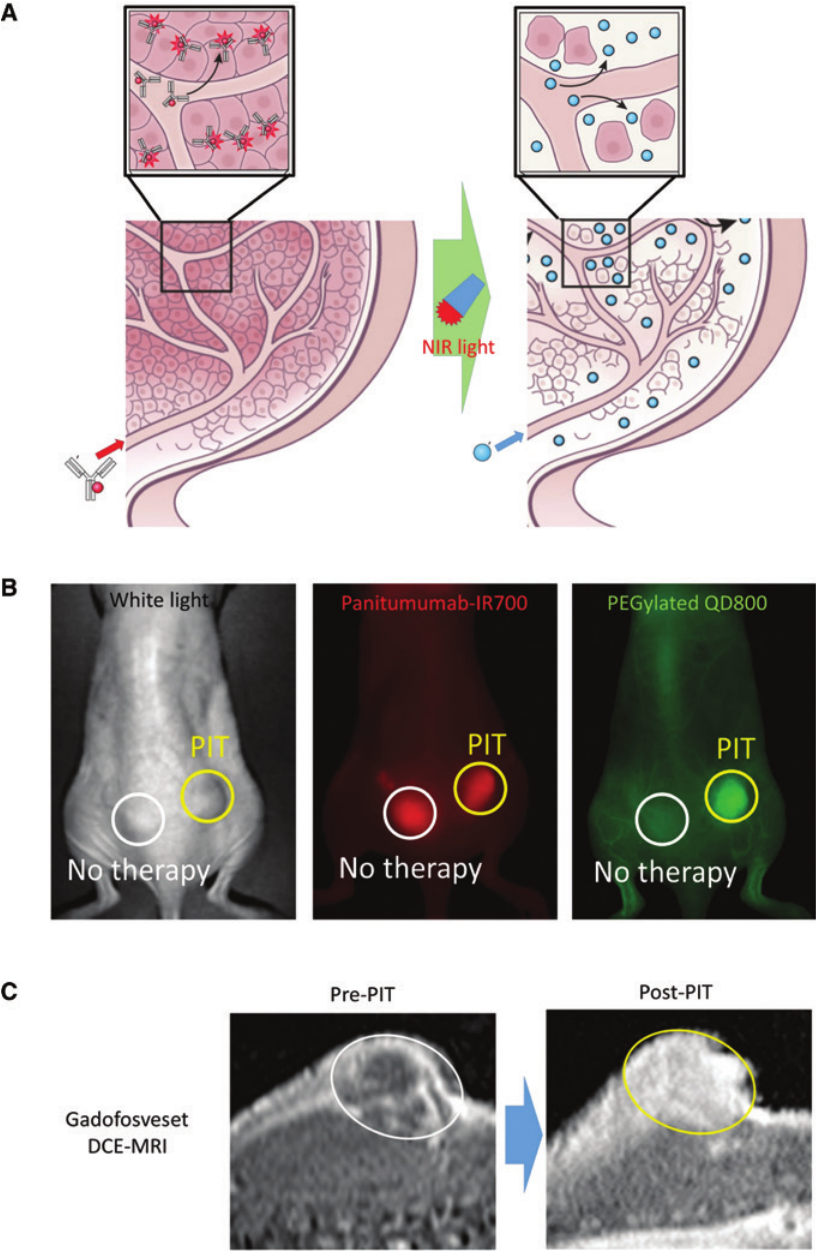
Figure 3 NIR-PIT induced SUPR